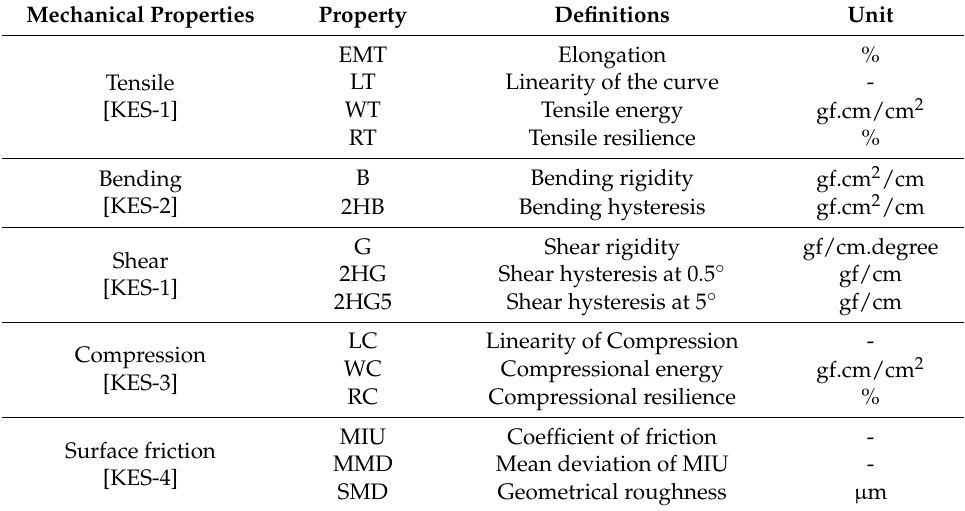
Table 2. Mechanical and surface properties used by Kawabata [13].